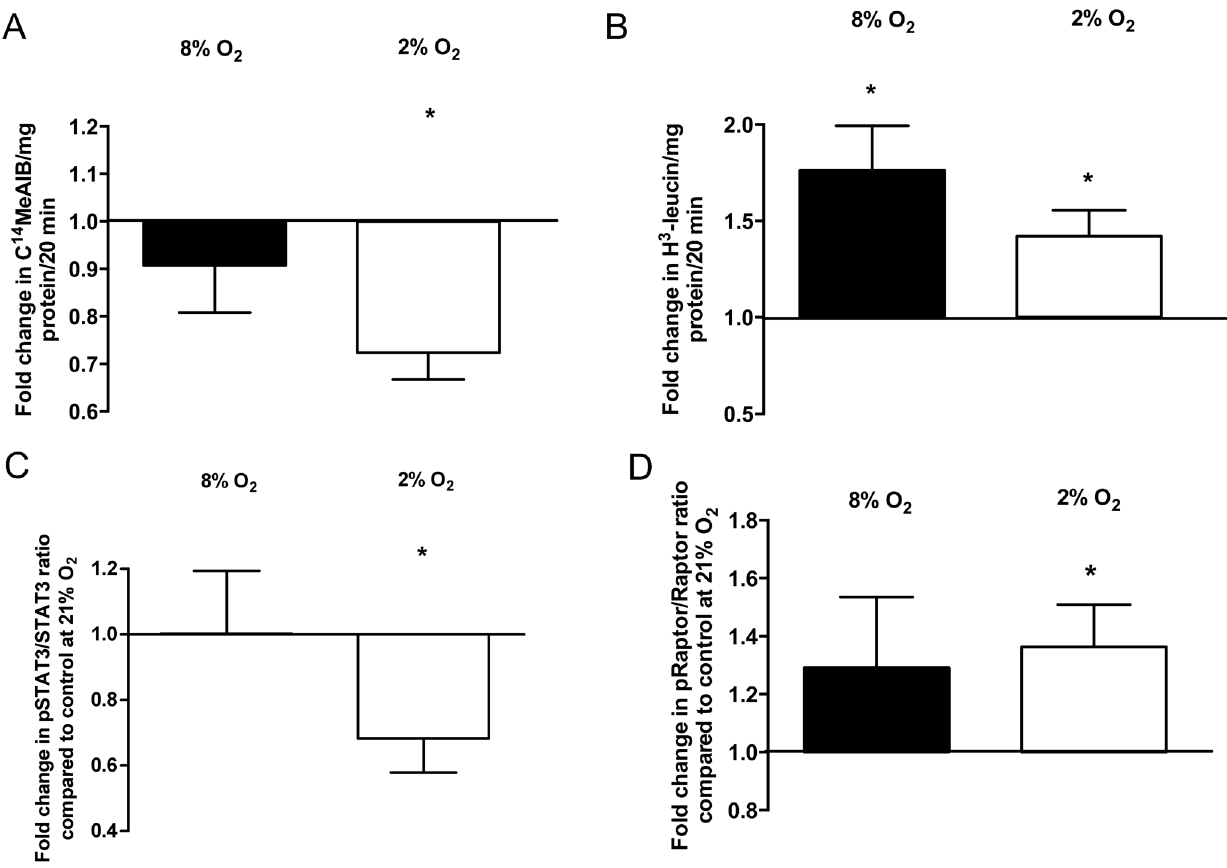
Figure 1. Relative placental system A (A) and L amino acid transporter activities (B) after 2 h of incubation of villous explants at 2% O 2 or 8% O 2 compared to 21% O 2 . Normalized ratio of pSTAT3/STAT3 (C) and pRaptor/Raptor (D) at different oxygen concentrations. Values are relative means 6 SEM. *p , 0.05 compared to system A and L activities or ratio of pSTAT3/STAT3 and pRaptor/Raptor incubated at 21% O 2 (set to 1).